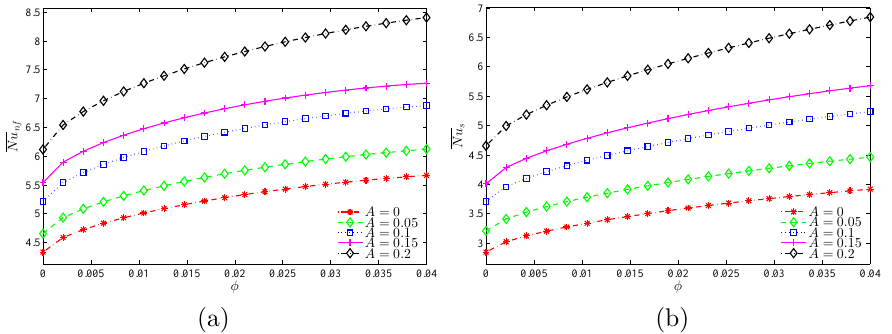
Figure 16. Variations of ( a ) the average Nusselt number of the nanofluid phase and ( b ) the average Nusselt number of the solid phase with φ for different A values at Da = 10 − 3 , γ = 10, and ε = 0.5. Figure 17 aims to examine the role of the porosity ( ε ) of the porous layer as a function of the Darcy number ( Da ) in the total heat transfer rates of the nanofluid and solid phases for the case of ε at φ = 0.02, γ = 10, and A = 0.1. At lower Darcy numbers ( Da ≤ 10 − 5 ), an increase in the porosity of the porous layer weakens the total heat transfer rates ( Nu nf and Nu s ) owing to the fact that high porosity at low permeability contributes to more heat resistance within the porous medium. The opposite is true for high Darcy numbers.